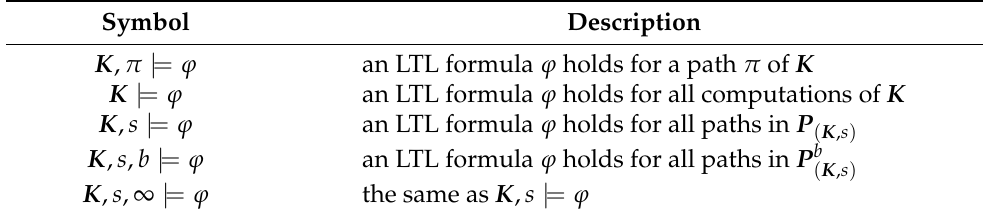
Table 3. Descriptions of satisfaction relation | = notations (or symbols), where b is a natural